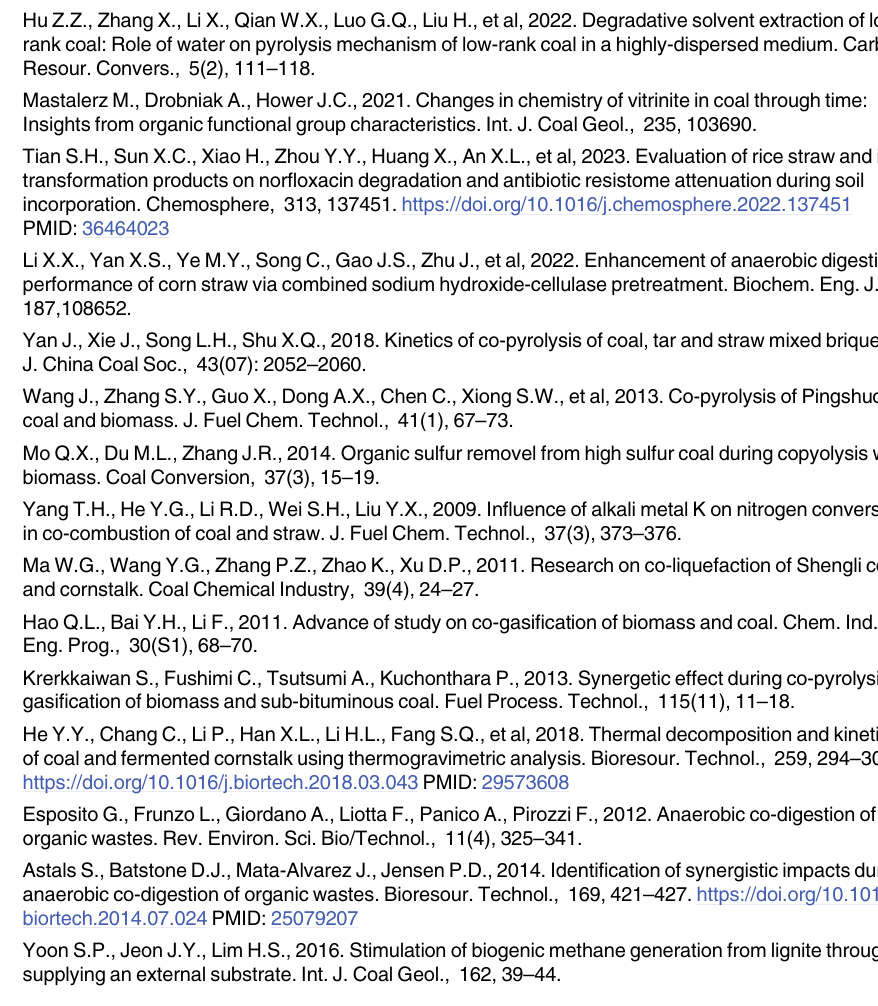
S2 Fig. Gas fermentation device diagram. The figure is derived from the self-designed and drawn gas production fermentation device, which is used for the combined production of methane from coal and